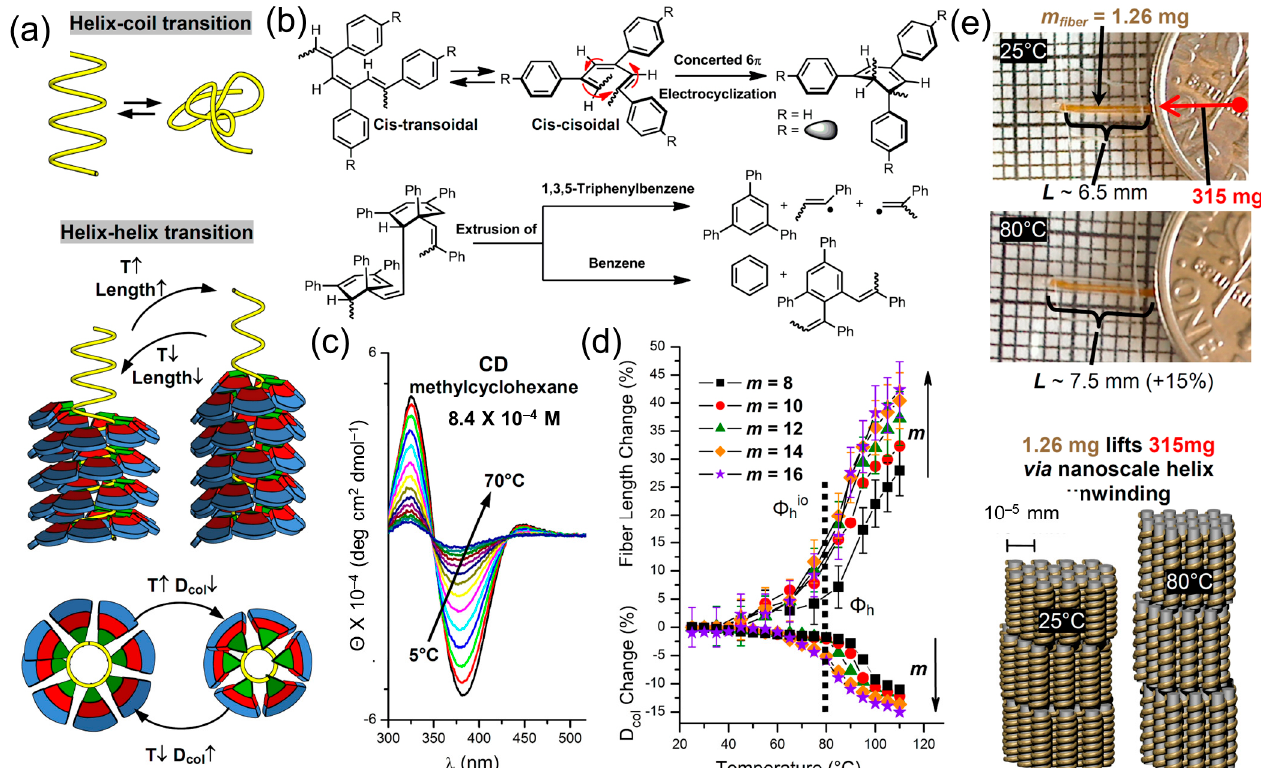
Figure 17. Molecular machine self-organized from dendronized helical polyphenylacetylenes. Illus- tration of the helix–coil transition and its transformation into a helix–helix transition that mediates expansion and contraction of the helical structure with temperature ( a ); expanded images collected by a digital camera at 25 °C and at 80 °C of the oriented fi ber ( b ); variable-temperature CD spectrum ( c ); comparison of the fiber length change from optical microscopy and column diameter from the fi ber XRD for the library of the polyphenylacetylenes with di ff erent peripheral alkyl chain length in the dendron (m) ( d ) [97,100]. The Figure is adapted from [97,100]. Copyright © 2005, American Chemical Society. Copyright © 2008, American Chemical Society.